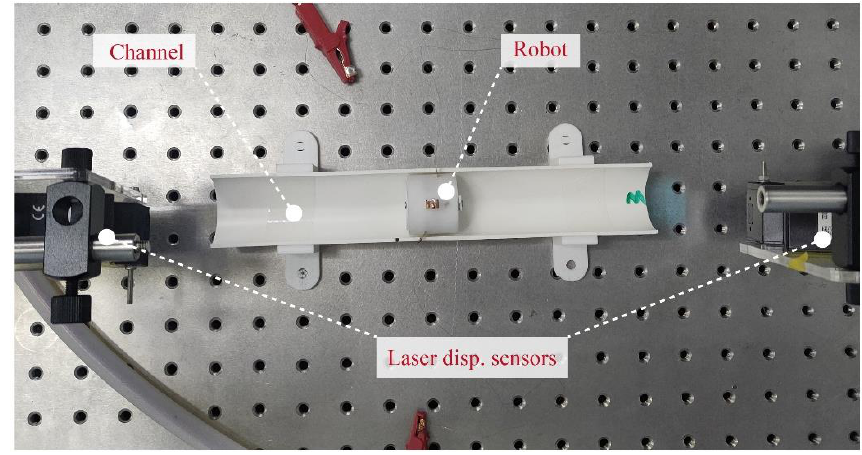
Figure 6. Experimental setup of the robot performance test.